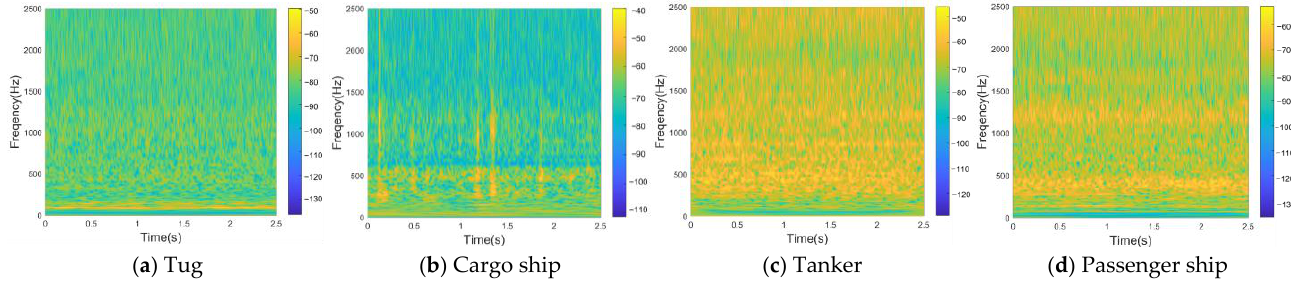
Figure 10. CQT of different types of ships.